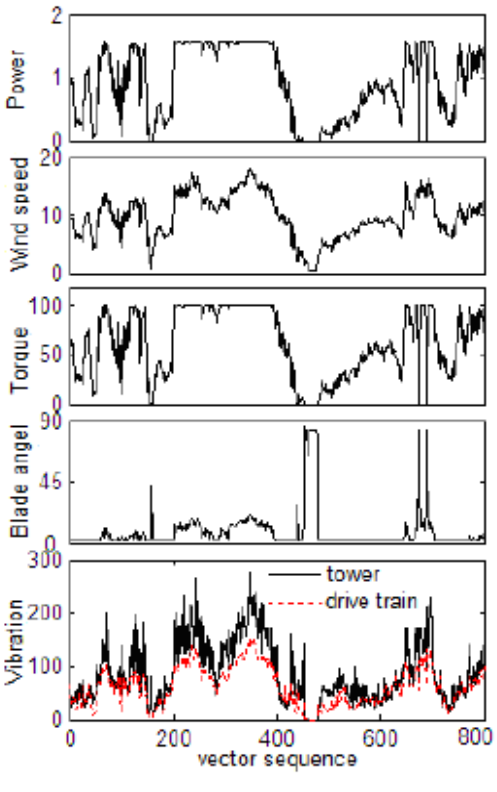
Figure 2. Trends for tower vibration and related variables with some operations above the rated